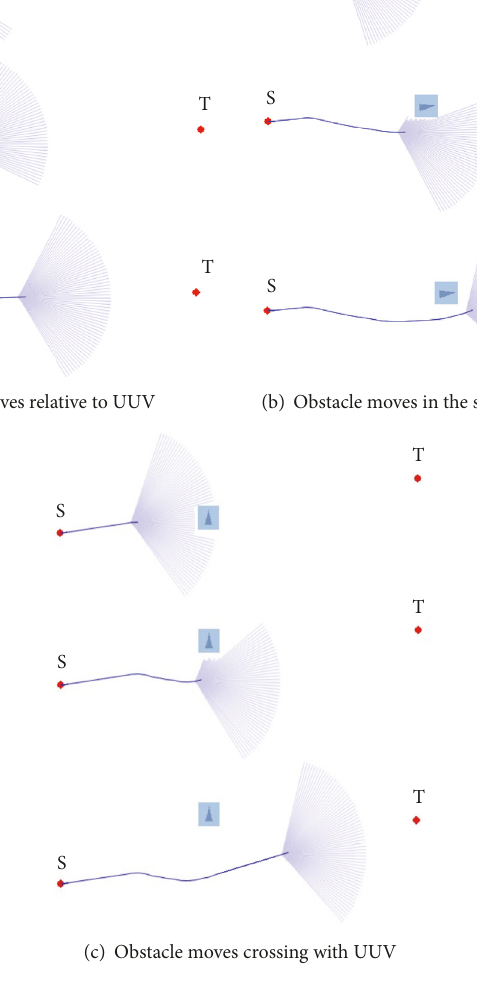
Figure 19: Online planning results of LSTM45 in several dynamic